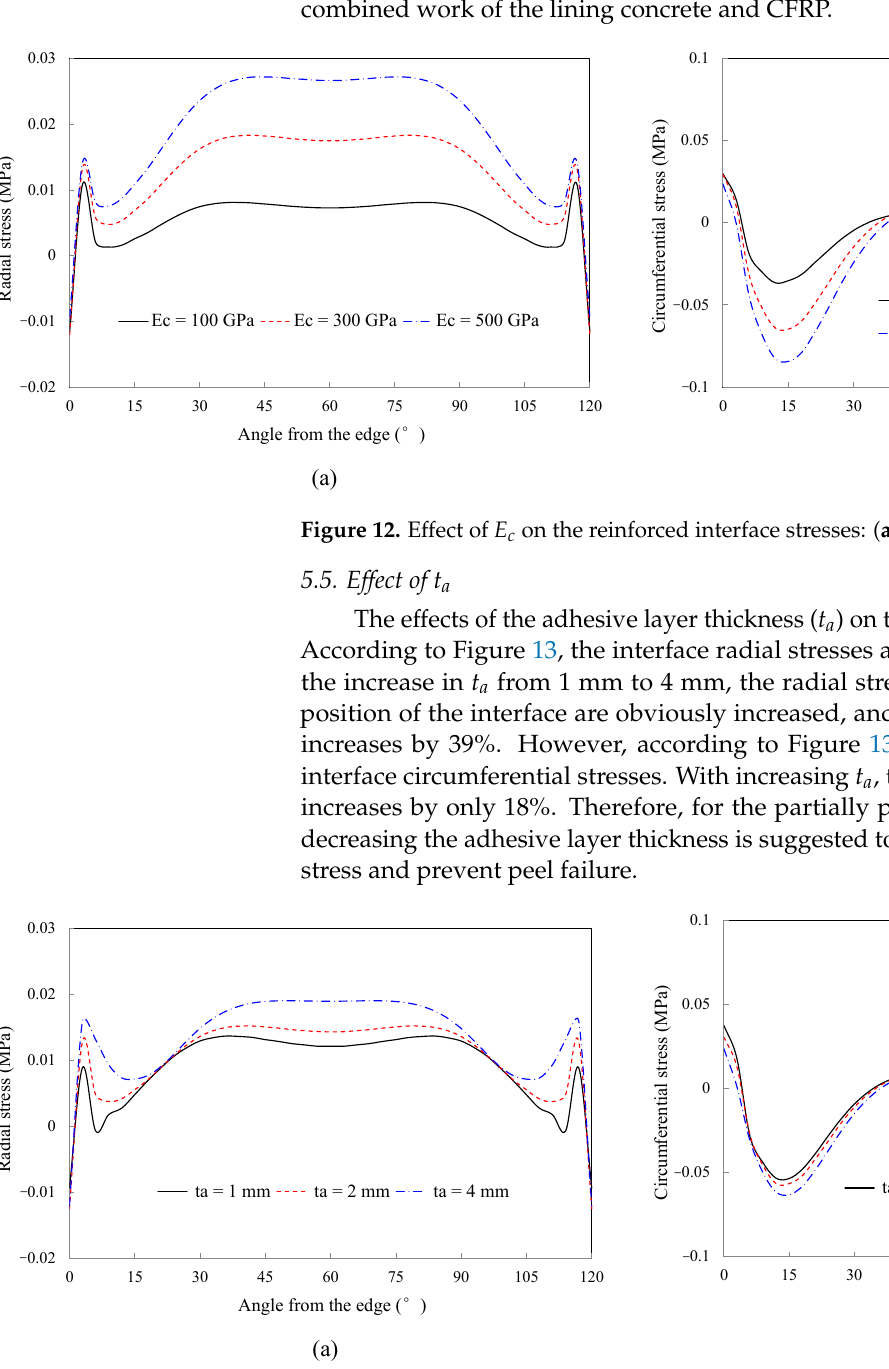
Figure 11. Effect of t c on the reinforced interface stresses: ( a ) radial stress; ( b ) circumferential stress.